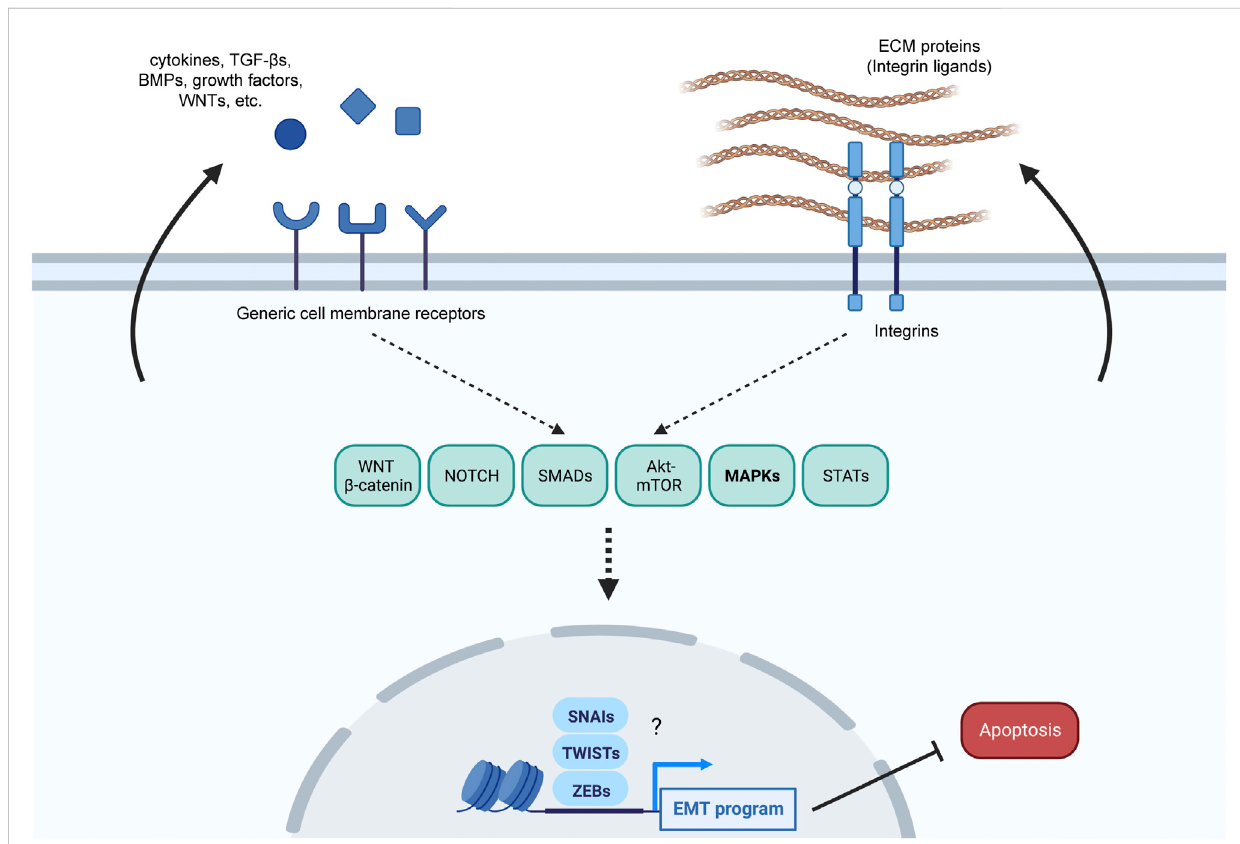
Overview of possible senescence-related pro-EMT pathways. Damaged cells might both respond to and produce pro-EMT factors to adjust their response to the extent of the damage suffered. Several pro-EMT factors such as secreted ligands (cytokines, TGF- β s, BMPs, growth factors, NOTCH ligands, WNTs) and ECM proteins that bind to integrins are produced by senescent cells and can further enhance senescence over apoptosis; the arrows arising from the cytosol towards the extracellular space represent possible autocrine loops. These ligands might be responsible for the modulation of several EMT-related pathways, including MAPKs, to implement an EMT program, which further relies on core pro-EMT transcription factors, including the SNAIs (SNAIL and SLUG), TWISTs (TWIST1 and TWIST2), and ZEBs (ZEB1 and